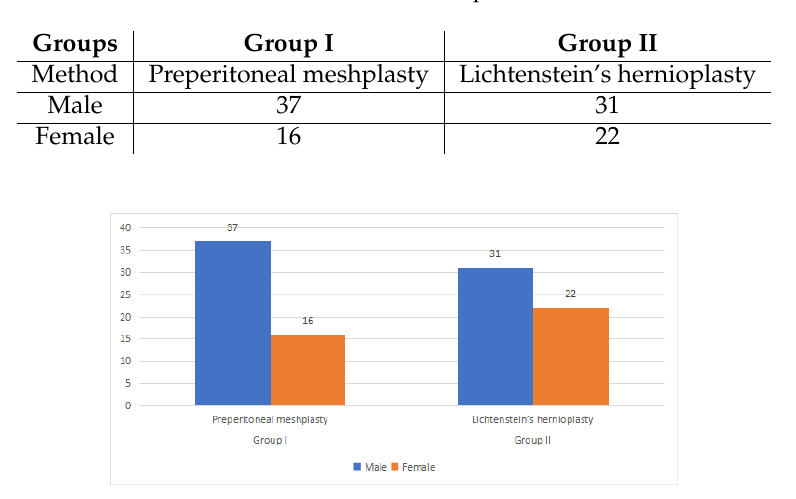
Figure 1. Graphically distribution of patients